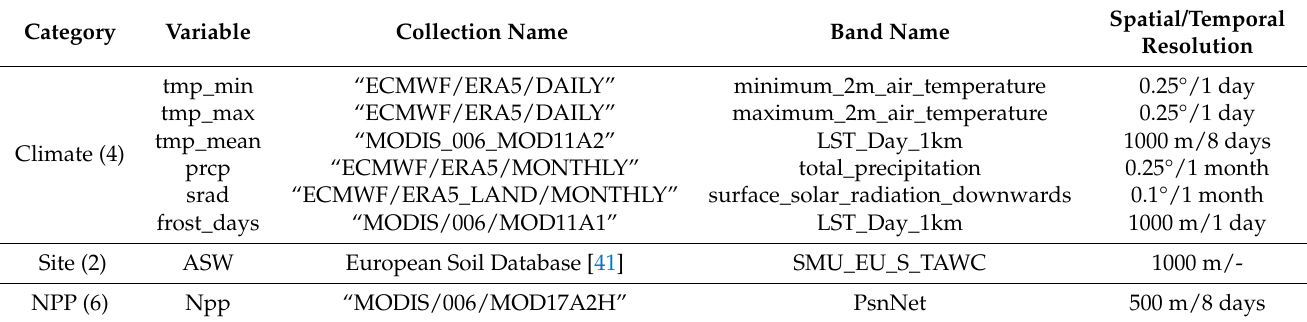
Table 2. Summary of data collected